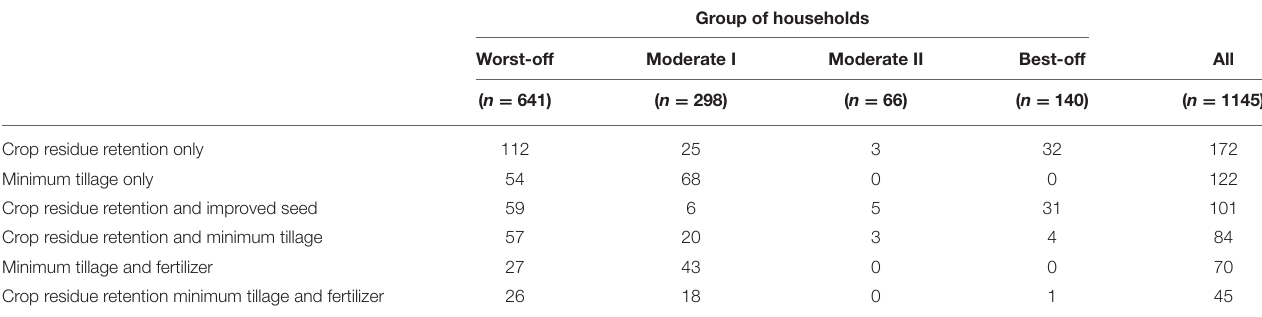
TABLE 6 | The number of households using management practices across target groups in Mozambique. sustainable intensification (SI) technologies in grey are excluded from further